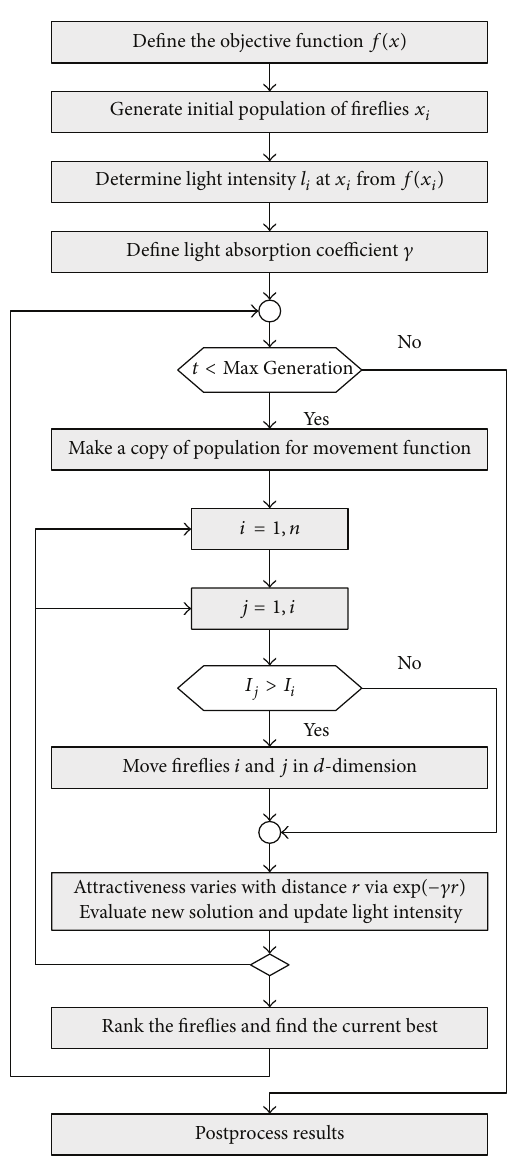
Figure 3: Flow chart of firefly